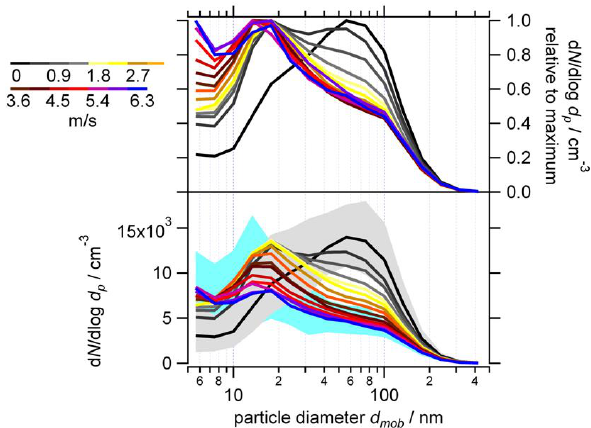
Fig. 10. EAS median number size distributions for different wind speeds. Upper panel: normalized to the highest value; lower panel: absolute values. Median size distributions of only the “Atlantic” air masses are shown; only wind speeds are included which were measured for at least 100min. Percentiles (25 and 75%) are shown exemplarily for wind speeds of 0ms − 1 (light grey) and 6.3ms − 1 (light